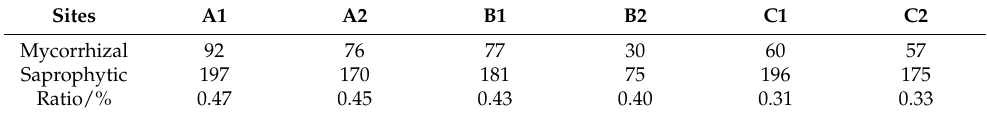
Table 3. Mycorrhizal:saprophytic macrofungi ratios of the investigation sites from Jilin Province. Sites A1